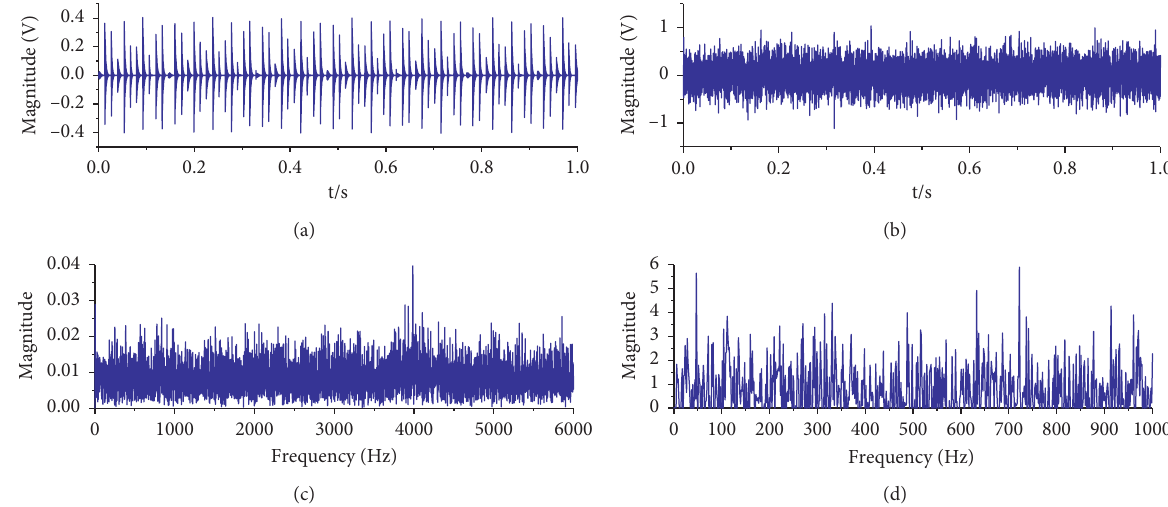
Figure 3: Waveform, spectrum, and envelope spectrum of the simulated signal. (a) Waveform of the impact signal. (b) Waveform of the simulated signal. (c) Spectrum of the simulated signal. (d) Envelope spectrum of the simulated signal.